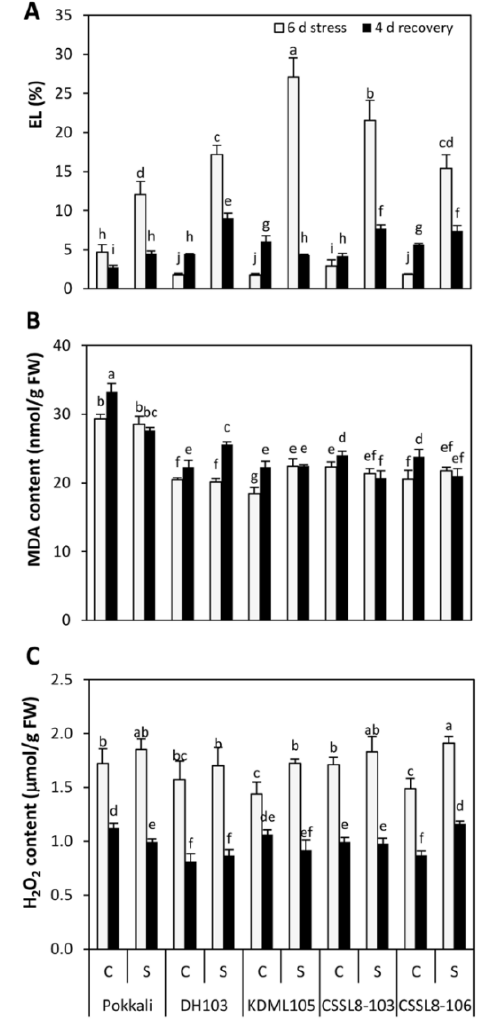
Figure 5. ( A ) Electrolyte leakage, ( B ) Malondialdehyde (MDA) content and ( C ) H 2 O 2 content of rice plants under control and salt stress for 6 days (light gray bars) and after recovery for 4 days (black bars). C, control; S, salt stress. For description of genotypes, see Figure 1. Values are means of four replications ± SE. Different letters indicate a significant difference in the means of each group ( p ≤ 0.05).